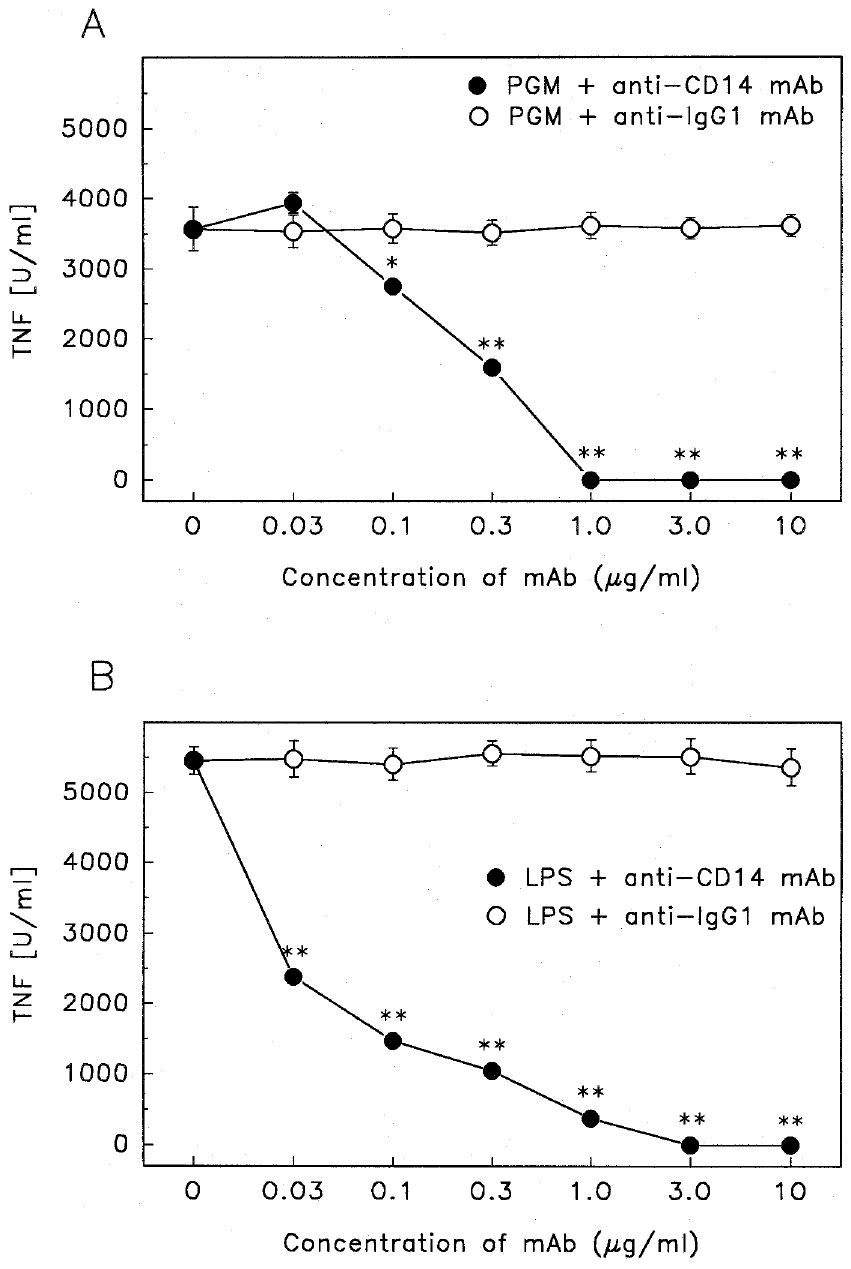
FIG. 2. Inhibition of peptidoglycan monomer (PGM)- and lipopolysaccharide (LPS)-induced tumor necrosis factor (TNF) release in mononuclear cells (MNC) by anti-CD14 monoclonal antibody (mAb) (MEM-18). MNC (4 ´ 10 6 /ml) were preincubated with increasing concentrations of anti-CD14mAb (MEM-18) or purified mouse IgG1 (MOPC21), which was used as an antibody isotype control for 1h at 4°C before stimulation with (A) PGM (30 m g/ml) or (B) LPS (10ng/ml). After 8h of incubation (in the presence of 10% human serum), supernatants were harvested and TNF activity was determined in the bioassay. Results represent the mean of triplicates ± SEM from one of three identical experiments. * p < 0.05, ** p < 0.01, PGM + anti-CD14mAb versus PGM + IgG1, LPS + anti-CD14 versus LPS +